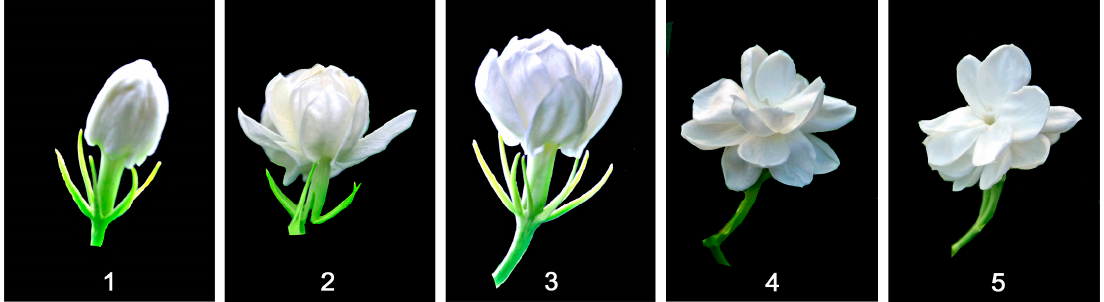
Figure 1. Five flowering stages of J. sambac ‘Bifoliatum’: ( 1 ) Flower at closed bud stage; ( 2 ) flower starts opening; ( 3 ) flower opening; ( 4 ) fully opened flower, and ( 5 ) flower starts senescence.